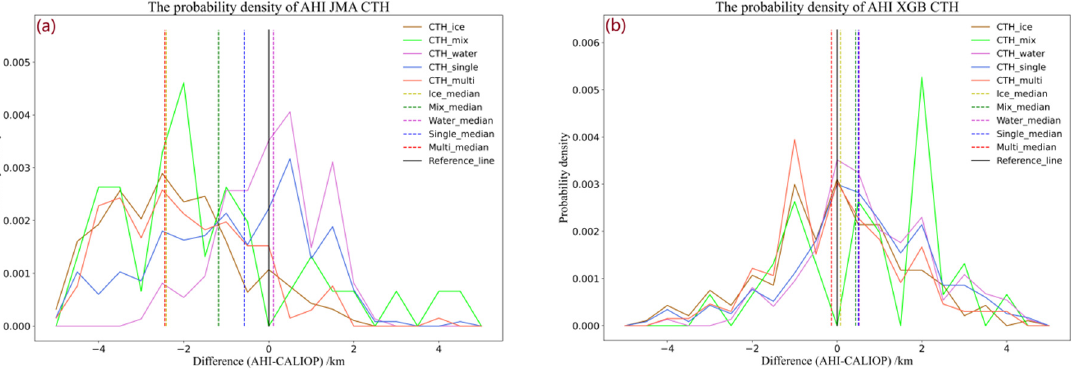
Figure 10. Probability density distribution of CTH products compared with CTH CAL under different cloud scenarios. ( a ) Himawari-8 L2 CTH; ( b ) XGBoost CTH.